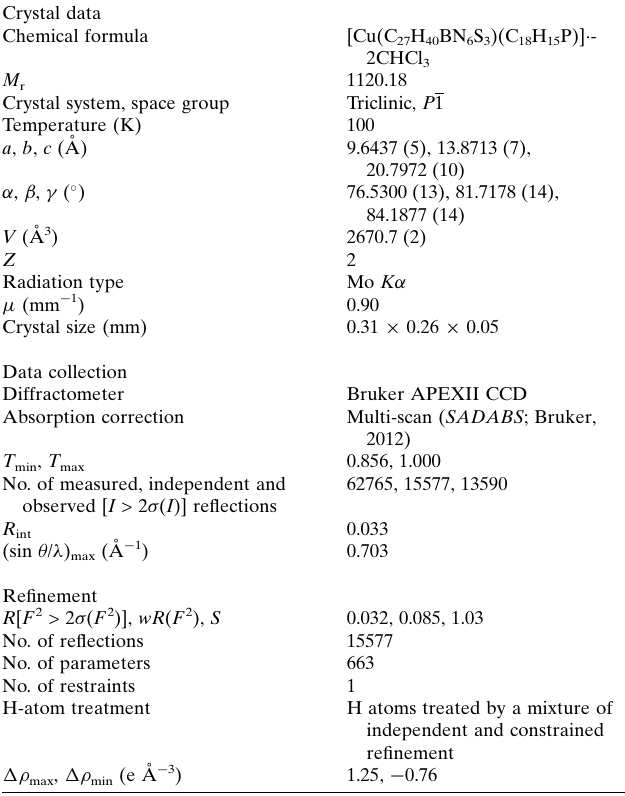
Table 3 Experimental details. Crystal data Chemical